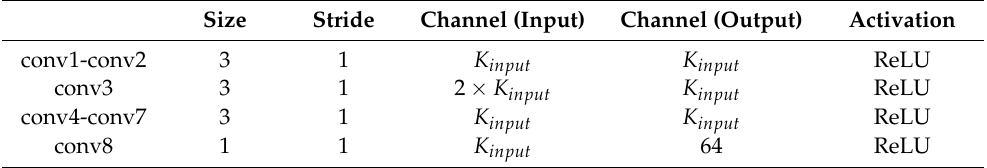
Table 2. The setting details of the DHFS module.